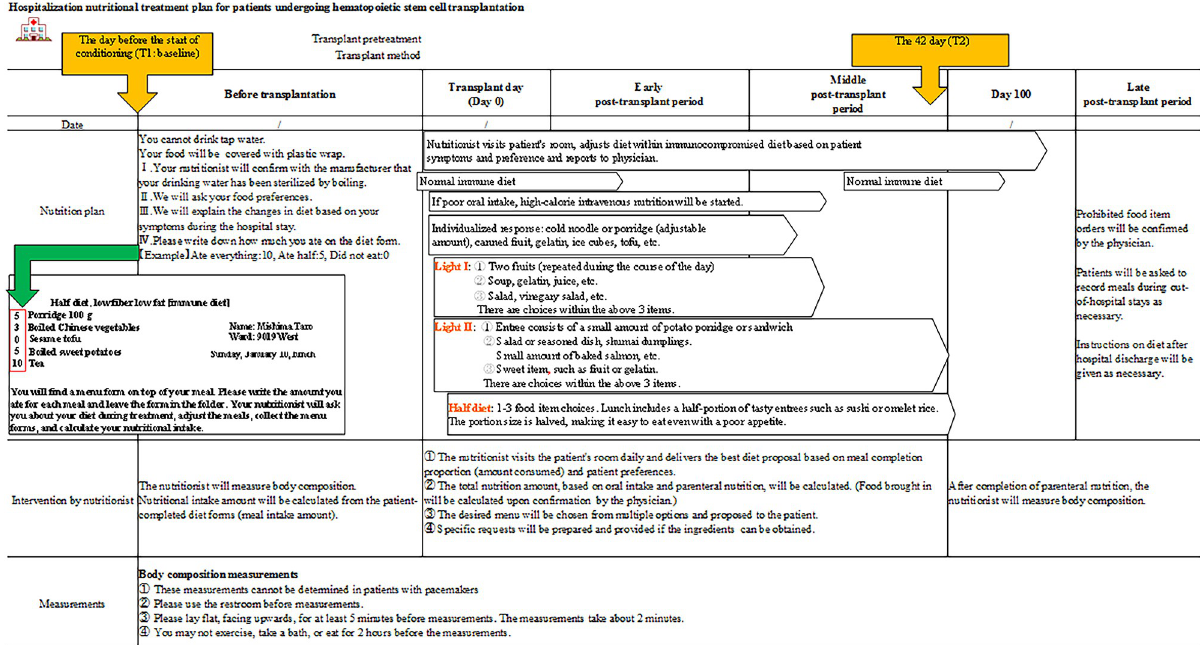
Fig 1. The nutritional pathway implemented based on nutritional guidance by the Shizuoka Cancer Center blood and hematopoietic cell transplantation team.